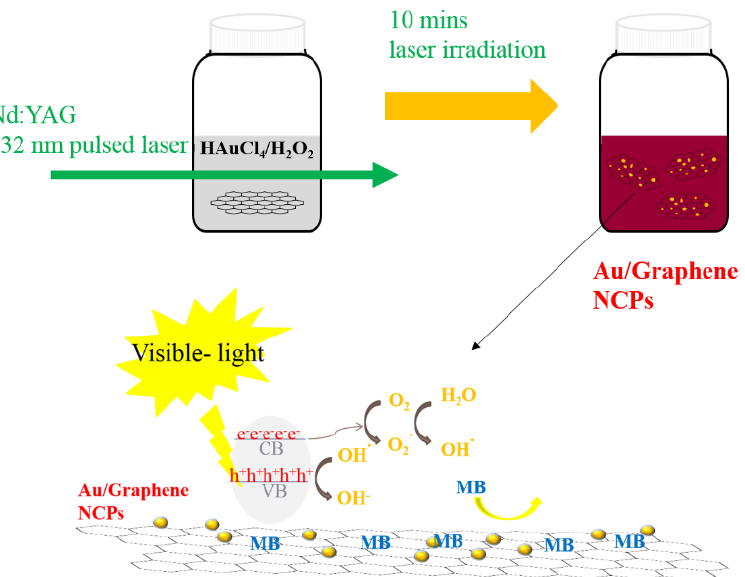
Figure 1. Schematic of the pulsed-laser-induced photolysis (PLIP) method to fabricate Au/Graphene nanocomposites (NCPs) used in visible photocatalysis.